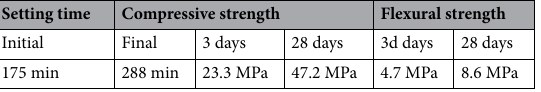
Table 2. Cement properties.